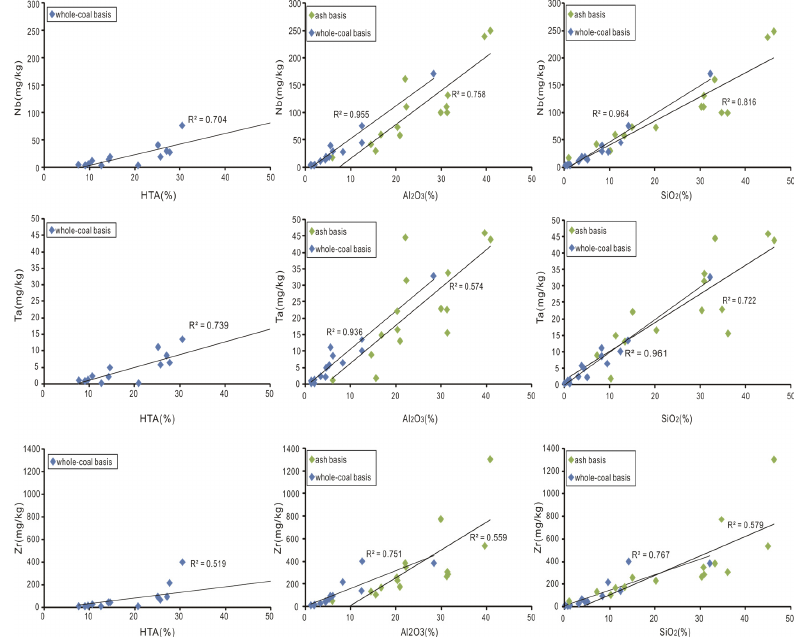
Figure 9. Relations between concentrations of Ta, Nb, and Zrwithhigh temperature ash (HTA) yield (whole-coal basis), Al 2 O 3 (whole-coal and ash basis), and SiO 2 (whole-coal and ash basis) contents in the Dongdong coals.